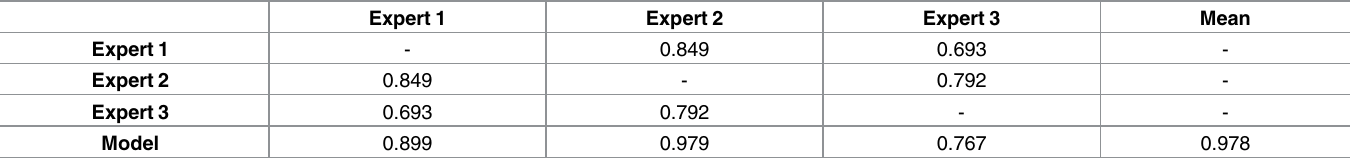
Table 3. Pearson’s correlation (r) between the three expertsscores and the output of the fuzzy subsystem 1 –quality of practice in the real dataset (n = 100). Expert 1 Expert 2 Expert 3 Expert